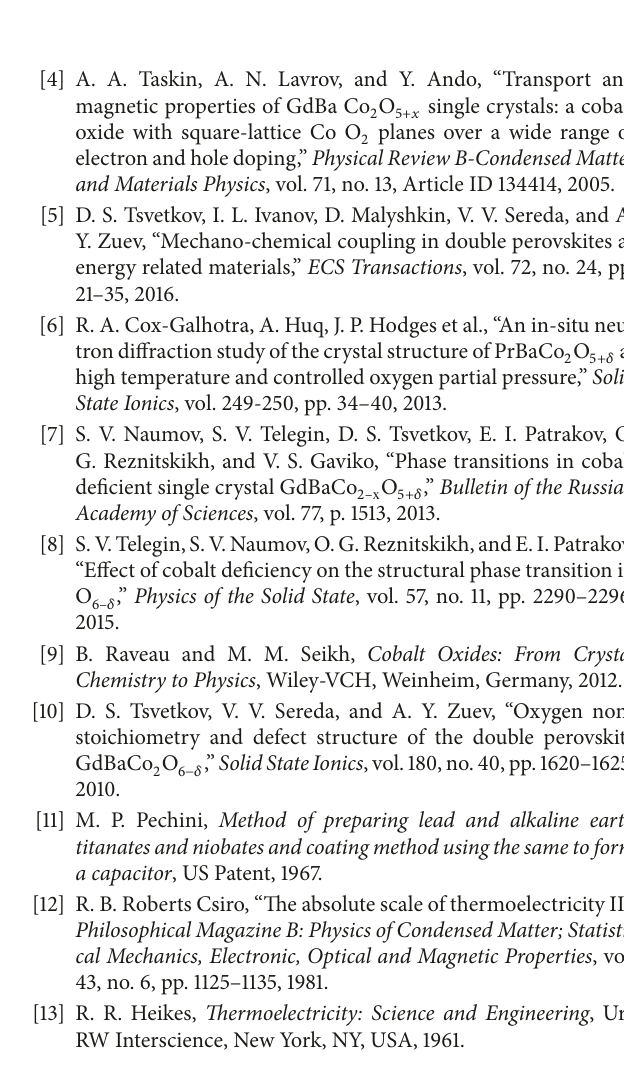
Figure 7: Overall conductivity as a function of temperature in air for (a) polycrystalline (ceramic) EuBaCo 2 O 6−𝛿 —(2.00) and EuBaCo 1.9 O 6−𝛿 —(1.90) samples and (b) single crystal EuBaCo 1.9 O 6−𝛿 sample measured parallel ([ 120 ])—( ab ) and perpendicular ([ 001 ])—( c ) to the growth